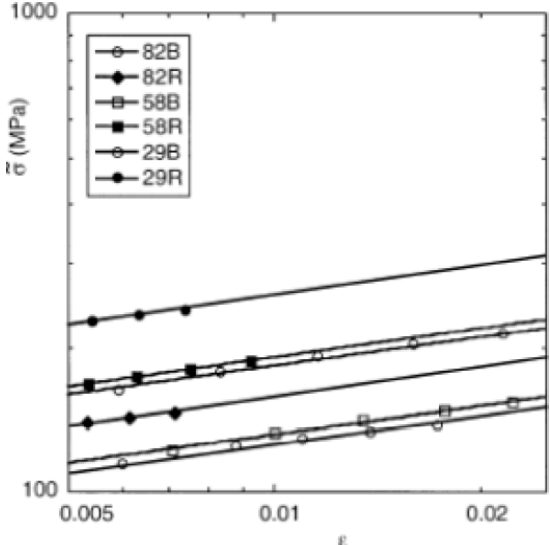
Fig. 3. Effective stress vs. strain (ln-ln plots) for the various B4C-Al composites. Reprinted with